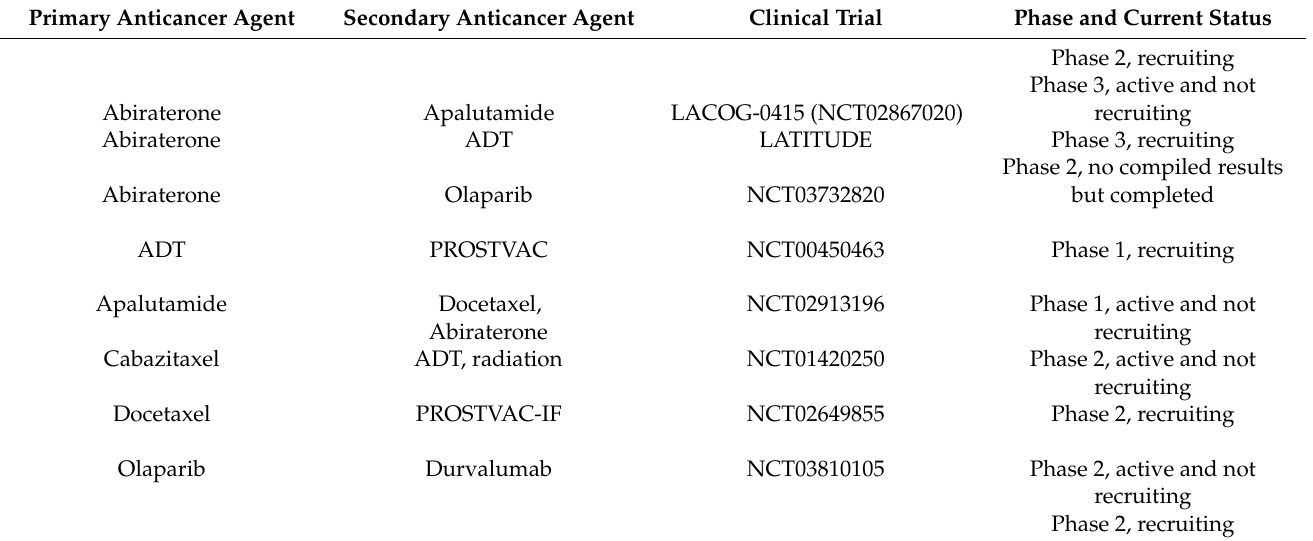
Table 6. Combination therapies for prostate cancer—ongoing clinical trials